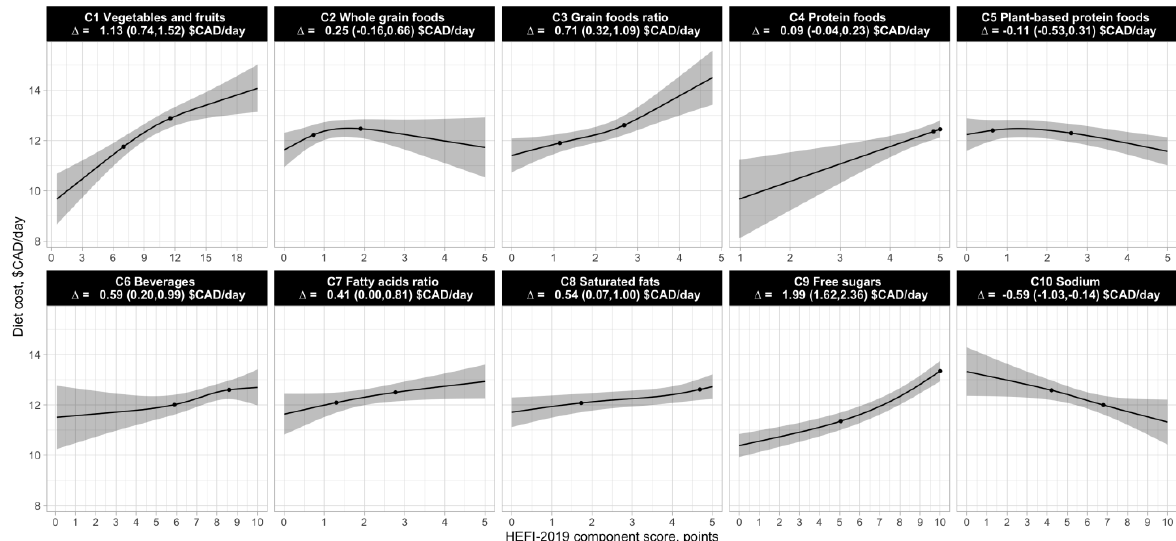
Figure 2. Linear regression of HEFI-2019 component scores and estimated daily diet costs adjusted for total energy intake in 1147 French-speaking adults from Quebec. Higher HEFI-2019 component scores indicate a greater adherence to individual recommendations in the 2019 CFG. The 25th and 75th percentiles of the HEFI-2019 component score distribution are represent by the black dots on the regression line. The estimates presented correspond to the usual daily diet cost difference between the 75th and 25th percentiles of the HEFI-2019 component score distribution. The 95% CI of the regression is represented by the shaded area. Estimated diet costs and dietary intake data were obtained using the National Cancer Institute’s multivariate method and reflect usual (i.e., long-term) intakes and costs. The 95% CI was estimated using 200 bootstrap resamples. CAD, Canadian dollars; HEFI-2019, Healthy Eating Food